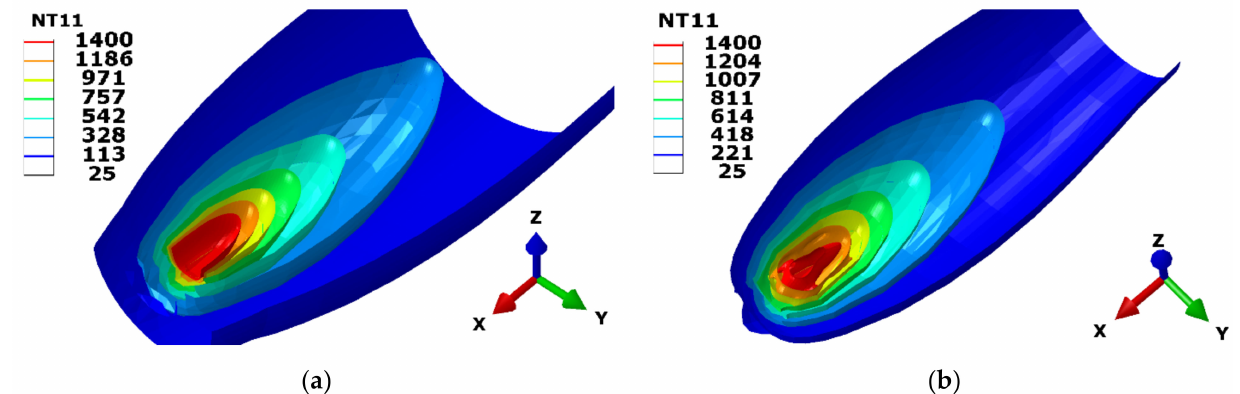
Figure 13. Temperature contour maps of nodal temperature in degree Celsius. Isometric view of melt pool: ( a ) Concentric heat model; ( b ) Goldak